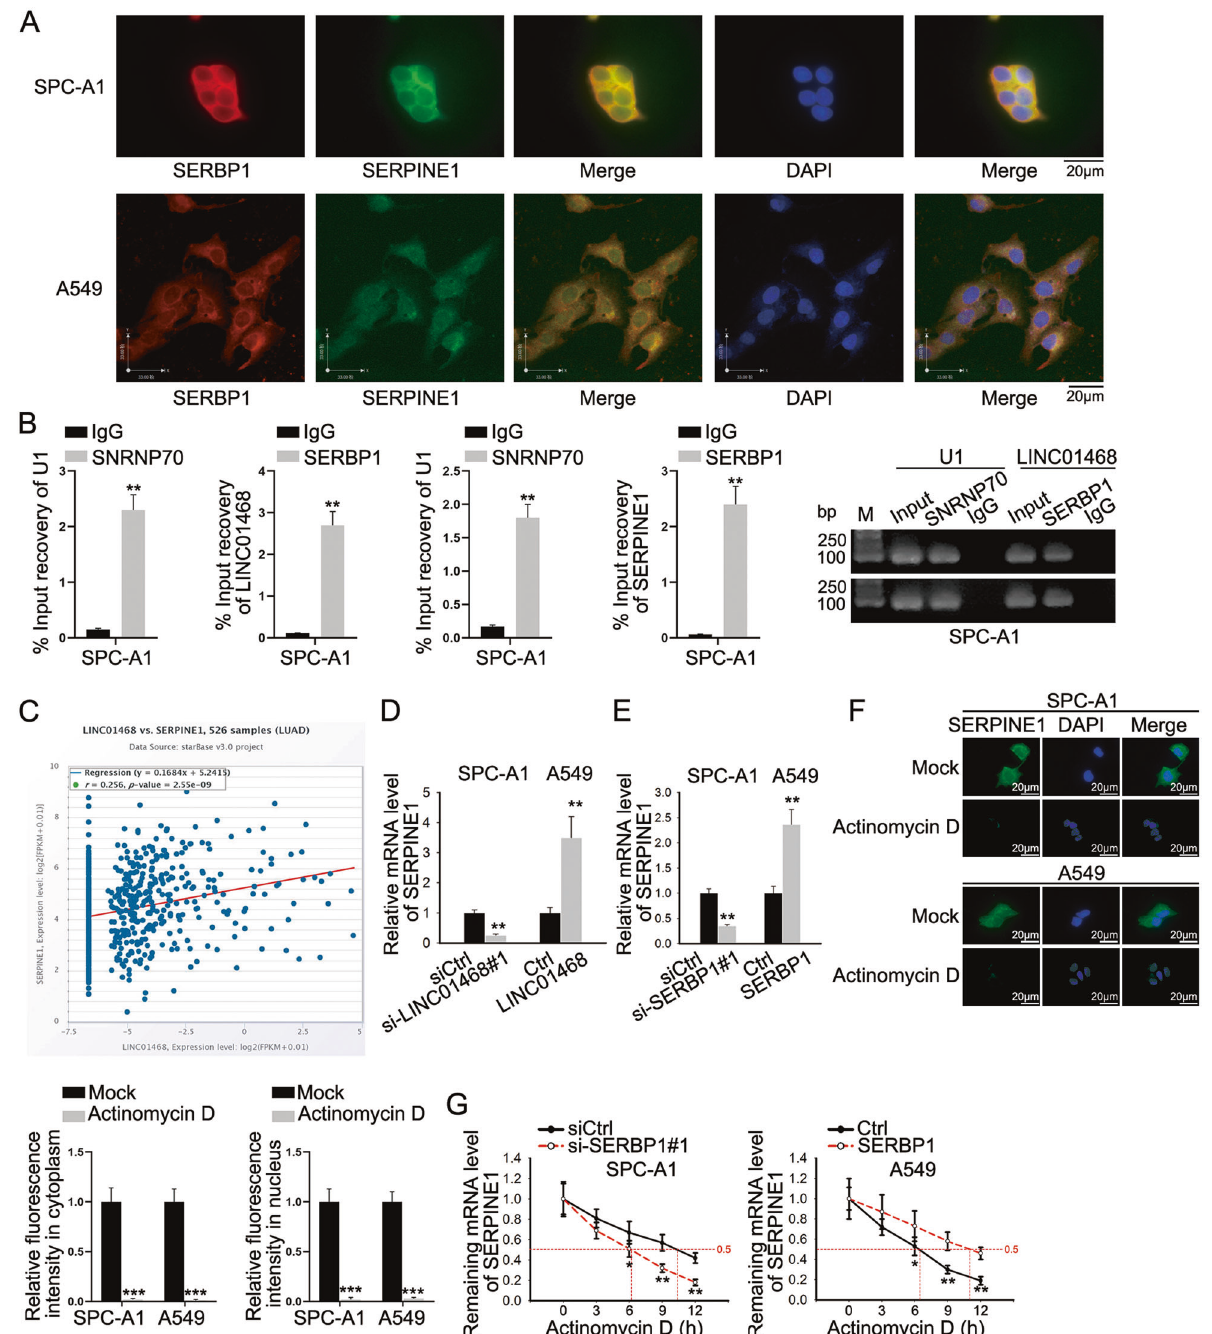
Fig. 5 LINC01468 stabilizes SERPINE1 mRNA by binding to SERBP1. A FISH-IF was applied to determine the cellular distribution of SERBP1 and SERPINE1. B RIP assay was done for assessment of the combination between SERBP1 and LINC01468/SERPINE1. C The correlation between LINC01468 and SERPINE1 expression in LUAD was predicted on starBase. D , E The mRNA level of SERPINE1 was measured via RT-qPCR in cells with silence or overexpression of LINC01468 or SERBP1. F The changes in cytoplasmic and nuclear accumulation of SERPINE1 under Actinomycin D addition were detected via FISH. G SERPINE1 mRNA stability was assessed in Actinomycin D-treated cells under the in fl uence of SERBP1 de fi ciency or overexpression. Results were exhibited as the mean ± SD on the basis of three independent experiments. * p < 0.05, ** p < 0.01 indicated the statistical signi fi cance of experiments